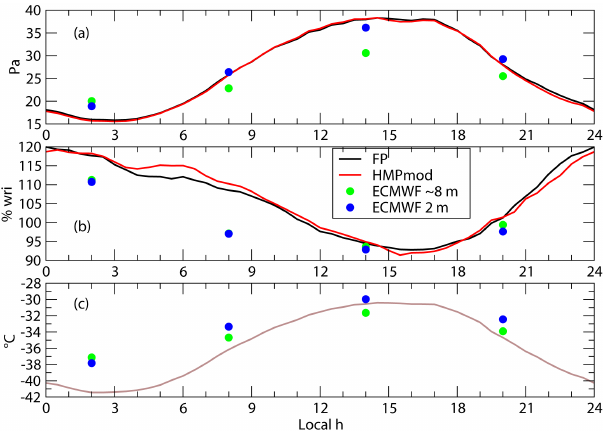
Figure 12. Mean December–January–February diurnal cycle of ob- served (FP and HMPmod) and analyzed (ECMWF, 2m and first model level at ∼ 8m) water vapor partial pressure (a) , relative hu- midity with respect to ice (b) and temperature (c) . The reference temperature is that from the unmodified HMP (brown curve in c ).